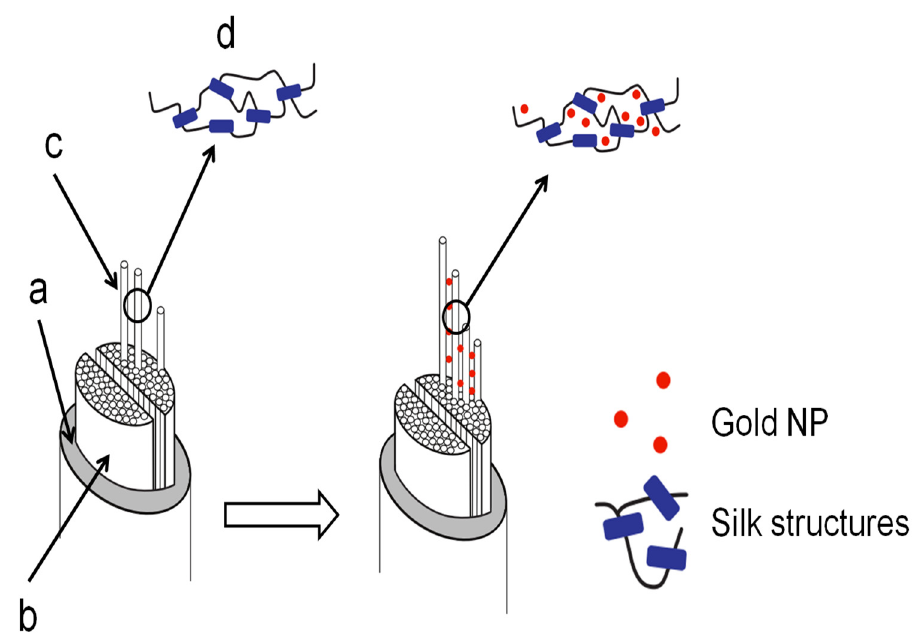
Figure 12. Gold NPs impregnation in silk. The typical silk fiber consists of ( a ) sericin coating, ( b ) fibroin brins, ( c ) fibrils, and ( d ) the secondary structure (idealized here the β -sheet as blue rectangles and the α -helices, random coils and turns as curvy black lines). After impregnation, the gold NPs were found in the inter-fibrillar spaces.